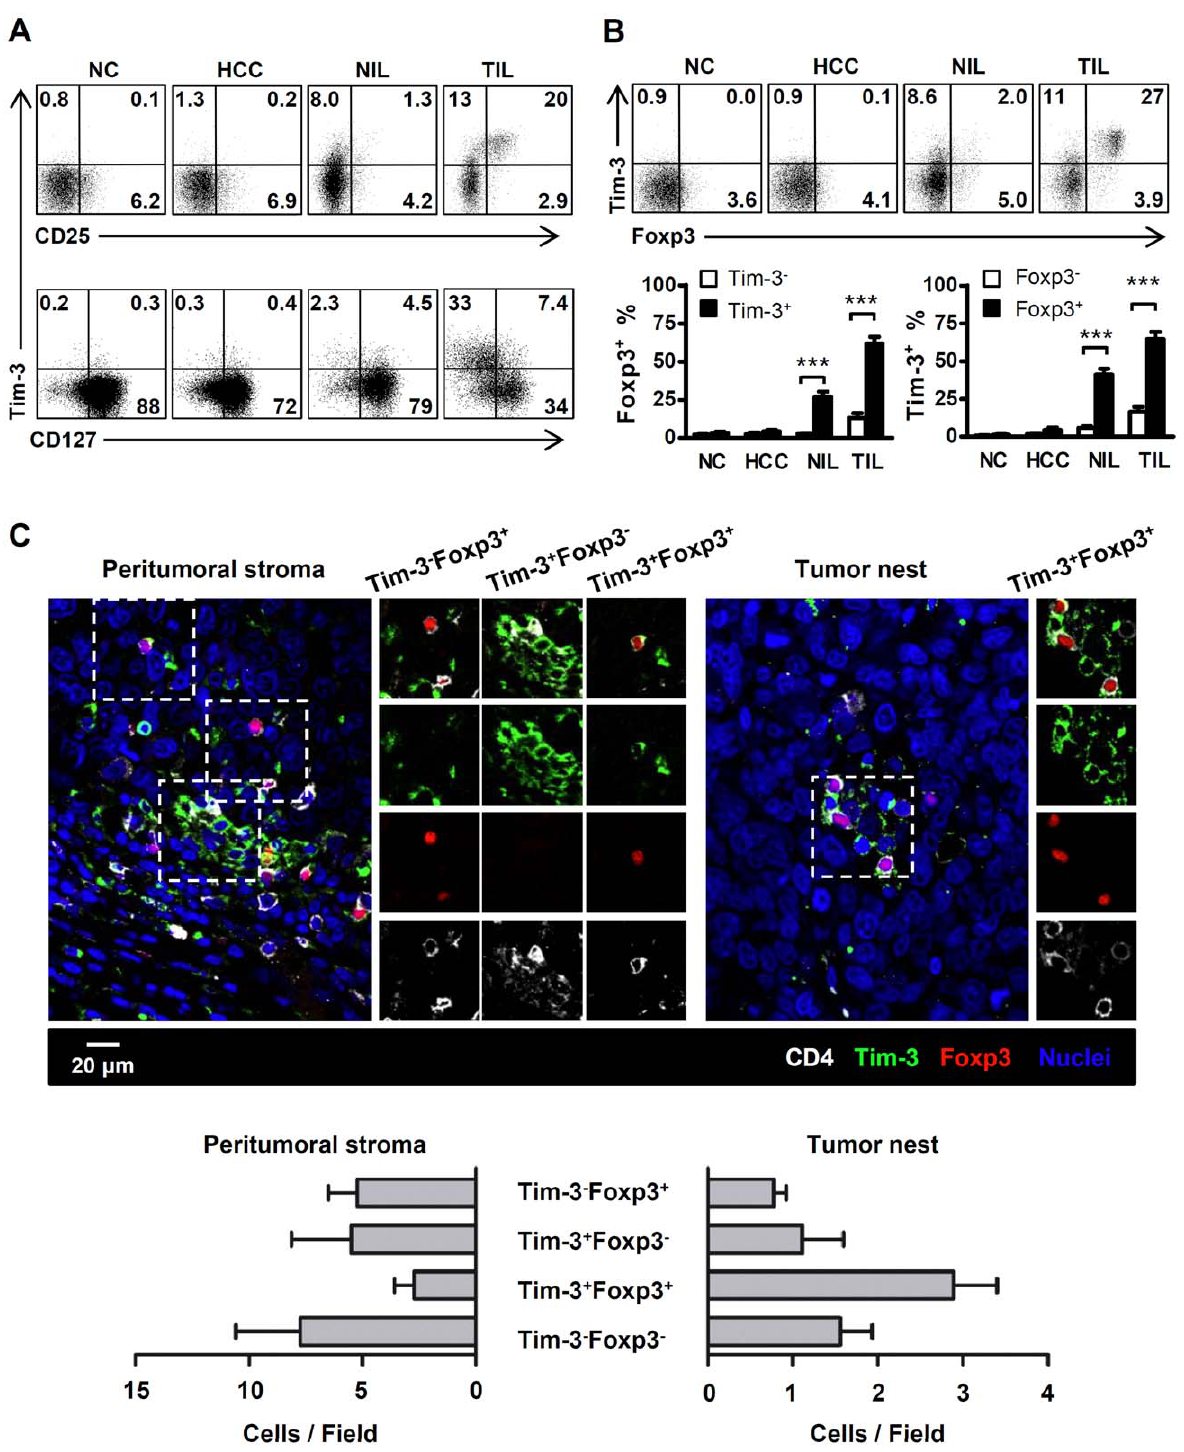
Figure 3. Tim-3 expression defines a population of CD4 T cells with Treg characteristics in TILs. A . Representative FACS analysis showing the association of CD25, CD127 and Tim-3 expression in CD4 T cells isolated from the PBMCs of normal healthy controls (NC, n =7) and HCC patients (HCC, n =6), and nontumor-infiltrating lymphocytes (NILs, n =18) and tumor-infiltrating lymphocytes (TILs, n =18) from HCC patients. B . FACS and statistical data showing that most tumor-infiltrating Tim-3 + CD4 T cells expressed the Treg-specific transcription factor Foxp3. Bars indicate the SEM; ***, P , 0.001. C . Paraffin-embedded HCC sections were subjected to multi-color immunofluorescence staining for CD4 (white), Tim-3 (green), Foxp3 (red) and nuclei (DAPI, blue). Confocal microscopic analysis revealing the different distribution of Tim-3 + Foxp3 + CD4 + cells in the peritumoral stroma and tumor nest of HCC. Images are representative of 13 samples. For the quantification of CD4 + Tim-3 + / 2 Foxp3 + / 2 cells, eight CD4 hot-spot fields per slide were taken with 40 6 oil-immersed objective lens. Numbers of each subset cells were counted manually by two independent, blinded observers.